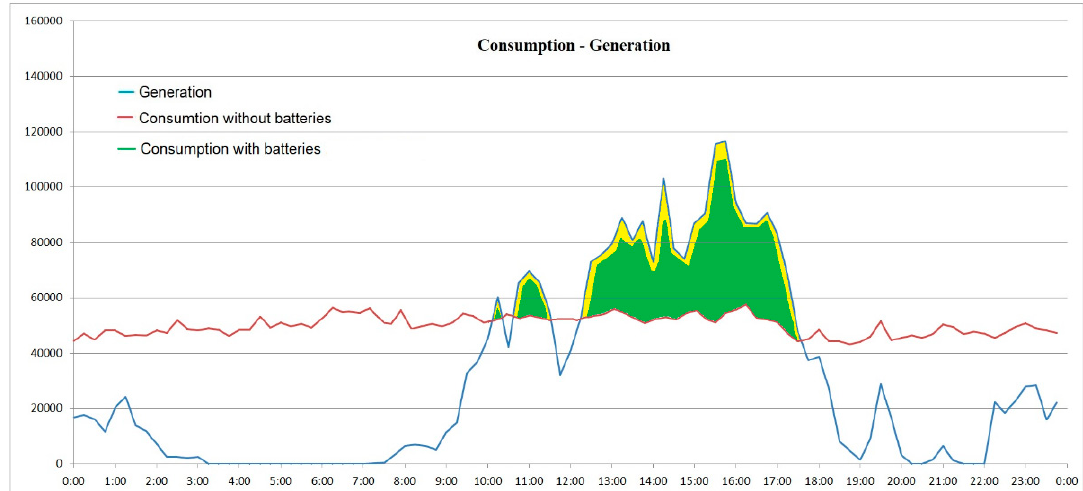
Figure 11. Daily grid generation–consumption graphic with batteries in manual mode (before implementation). Source: prepared by authors based on the results of this study.